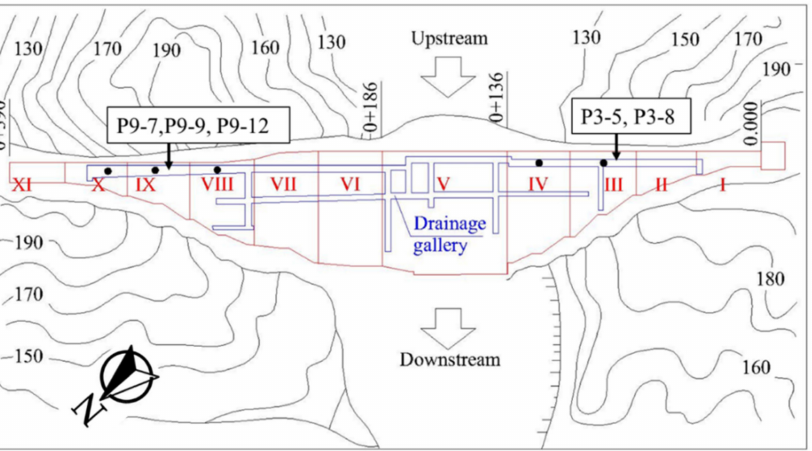
Figure 3. Top view of the dam. The black circles represent the boreholes where tracer tests were conducted. Locations of boreholes where SBDT was conducted are shown by two black circles which represent P9-7, P9-9, P9-12, and P3-5, P3-8, respectively.